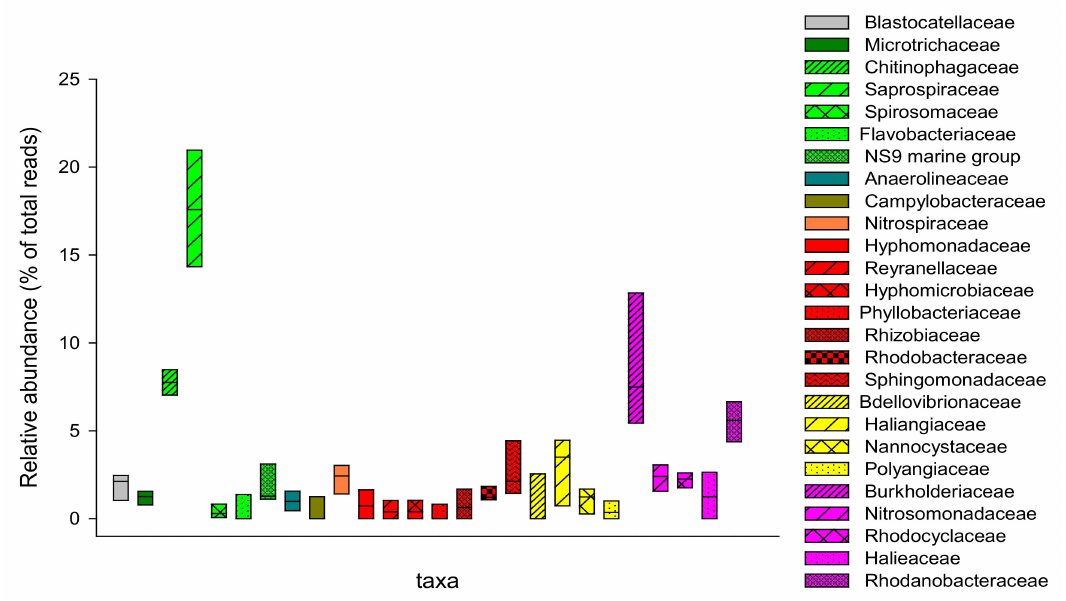
Figure 3. Box plot showing the relative abundance (as % of total reads) of the bacterial families ( ≥ 1% of total reads) in secondary sludge sampling along four different periods.